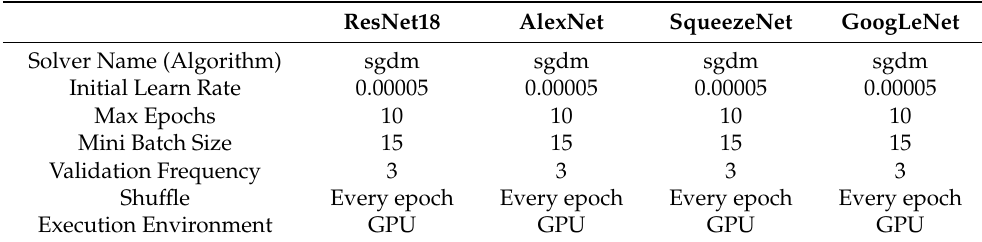
Table 9. Comparing parameters of the four methods.